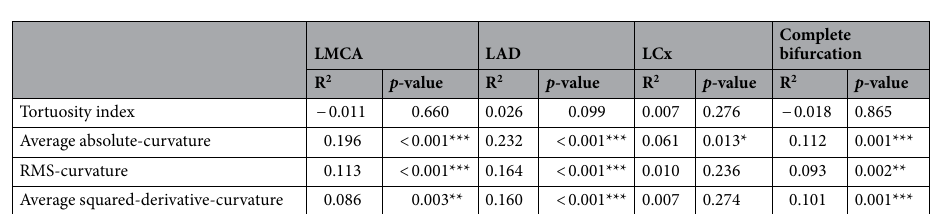
Table 4. Tortuosity metrics statistical correlation to the low TAWSS < 0.4 Pa normalized vessel area coverage. Higher R 2 indicates better performance, i.e. the predictors account for a larger proportion of the variance observed in TAWSS. Note that R 2 has been adjusted for multiple predictors and hence may be negative particularly for underperforming models. * p ≤ 0.05; ** p ≤ 0.01; *** p ≤ 0.001.